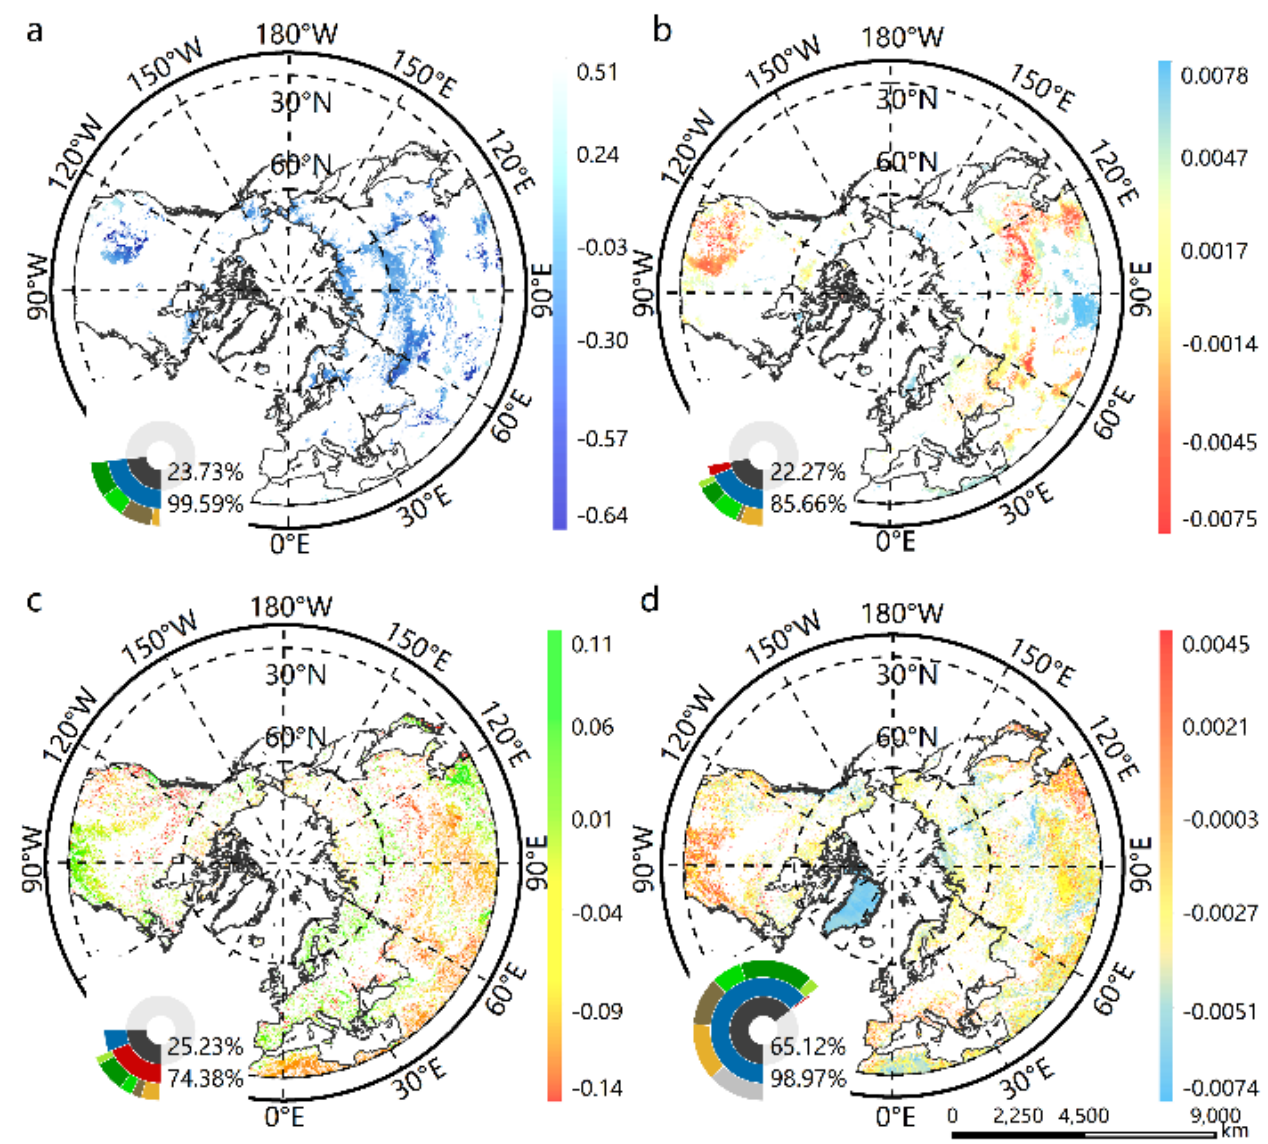
Figure 3. Spatial distribution of significant trends in annual mean SC ( a ), SM ( b ), LAI ( c ) and blue-sky albedo ( d ). Areas with p values higher than 0.05 are showed in white, and the colored regions are characterized by a 95% confidence interval. Insets at the bottom left show the percentages of pixels with a significant trend (dark gray), a significant increasing trend (red) and a significant decreasing trend (blue), respectively. Insets at the bottom left also show the percentages of pixels with a significant decreasing trend in ( a , b , d ) in different land cover types, and the percentage of pixels with a significant increasing trend in ( c ) in different land cover types, with colors corresponding to the colors in the legend in the Figure